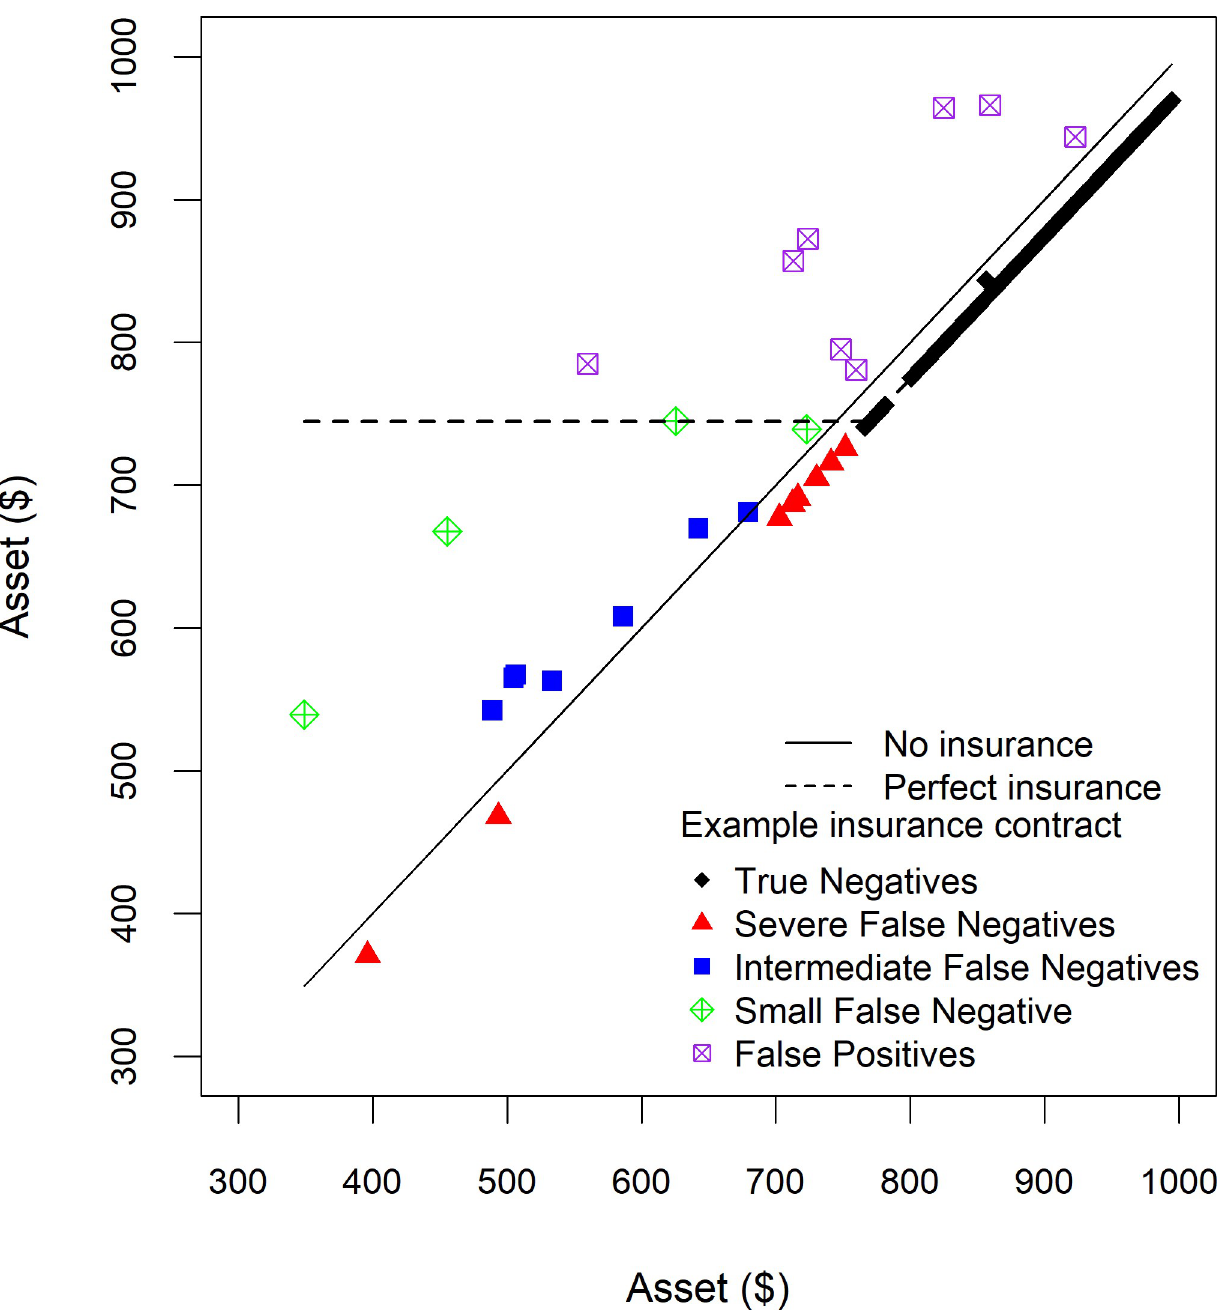
Fig 6. Quality of a hypothetical index insurance contract based on the segmented ( sm) regression model with LMD data (R 2 of 0.47 and RIB of 0.5) for 8 years and 15 sub-locations in Marsabit, Kenya (points), compared to a perfect insurance contract and to no insurance (lines). The following classification was used for the contract: True Negatives: No payment due and none paid; Severe False Negatives: contract underpays by more than 30%; Intermediate False Negatives: contract underpays between 10% and 30%; Small False Negative: contract underpays less than 10%, and False Positives: contract